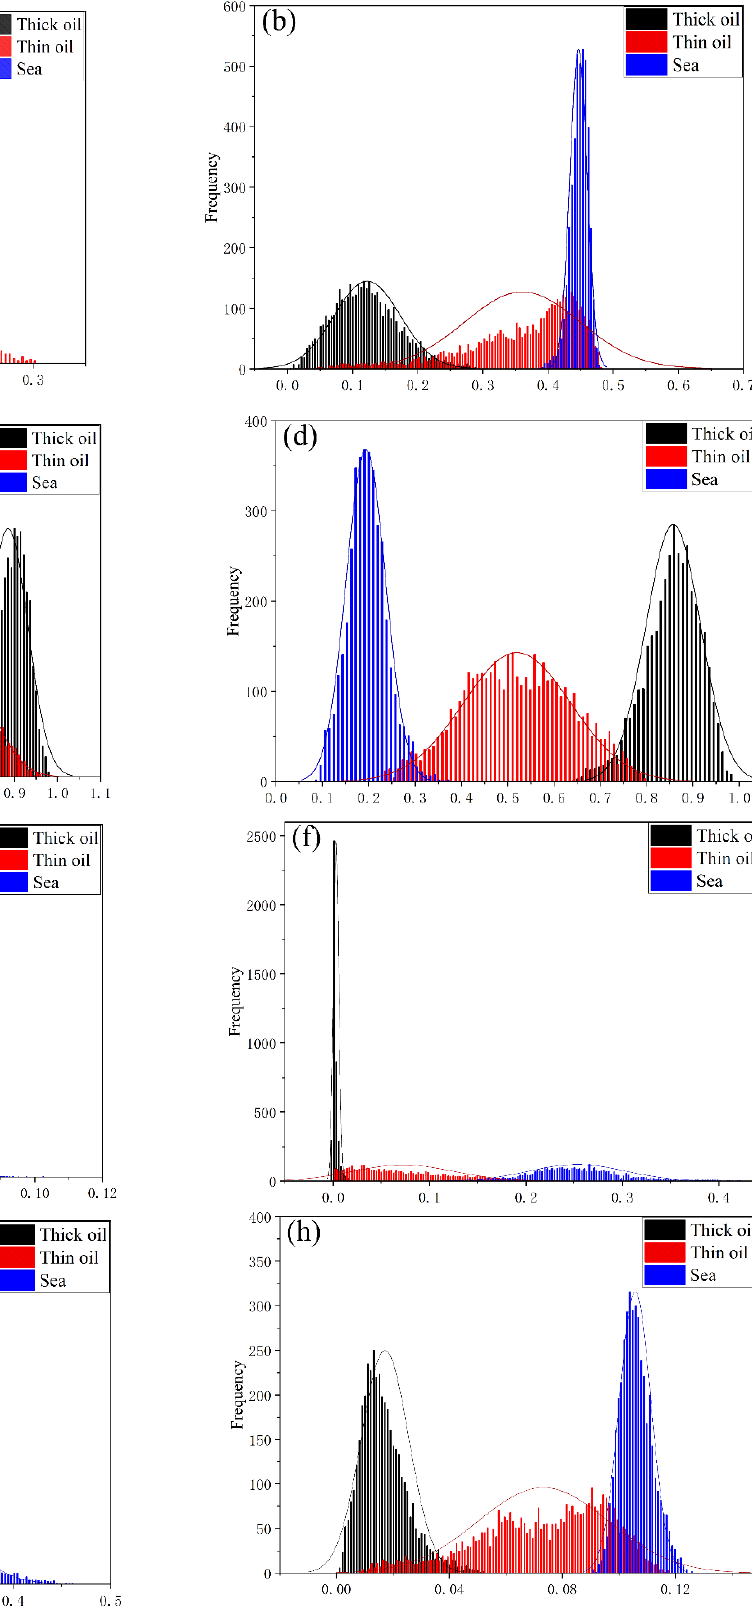
Figure 7. Histograms and distributions of target samples under different combinations of parameters. ( a ) H * A . ( b ) H * A 12 . ( c ) H *(1 − A ). ( d ) H *(1 − A 12 ). ( e ) A *(1 − H ). ( f ) A 12 *(1 − H ). ( g ) (1 − H )*(1 − A ). ( h ) (1 − H )*(1 − A 12 ).